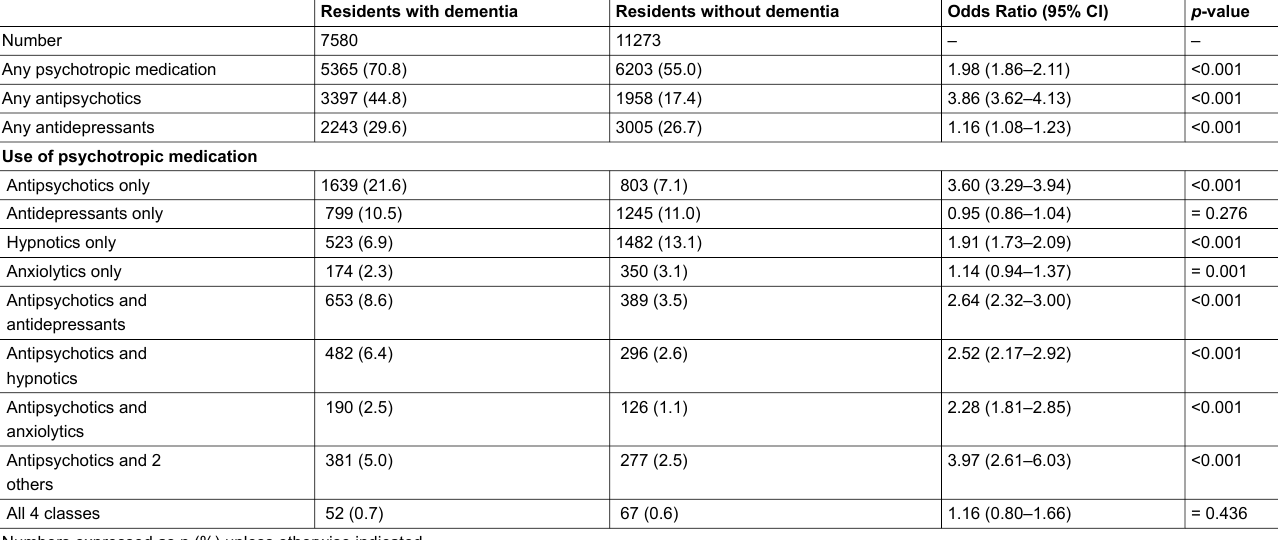
Table 2: Psychotropic medication use at the entry